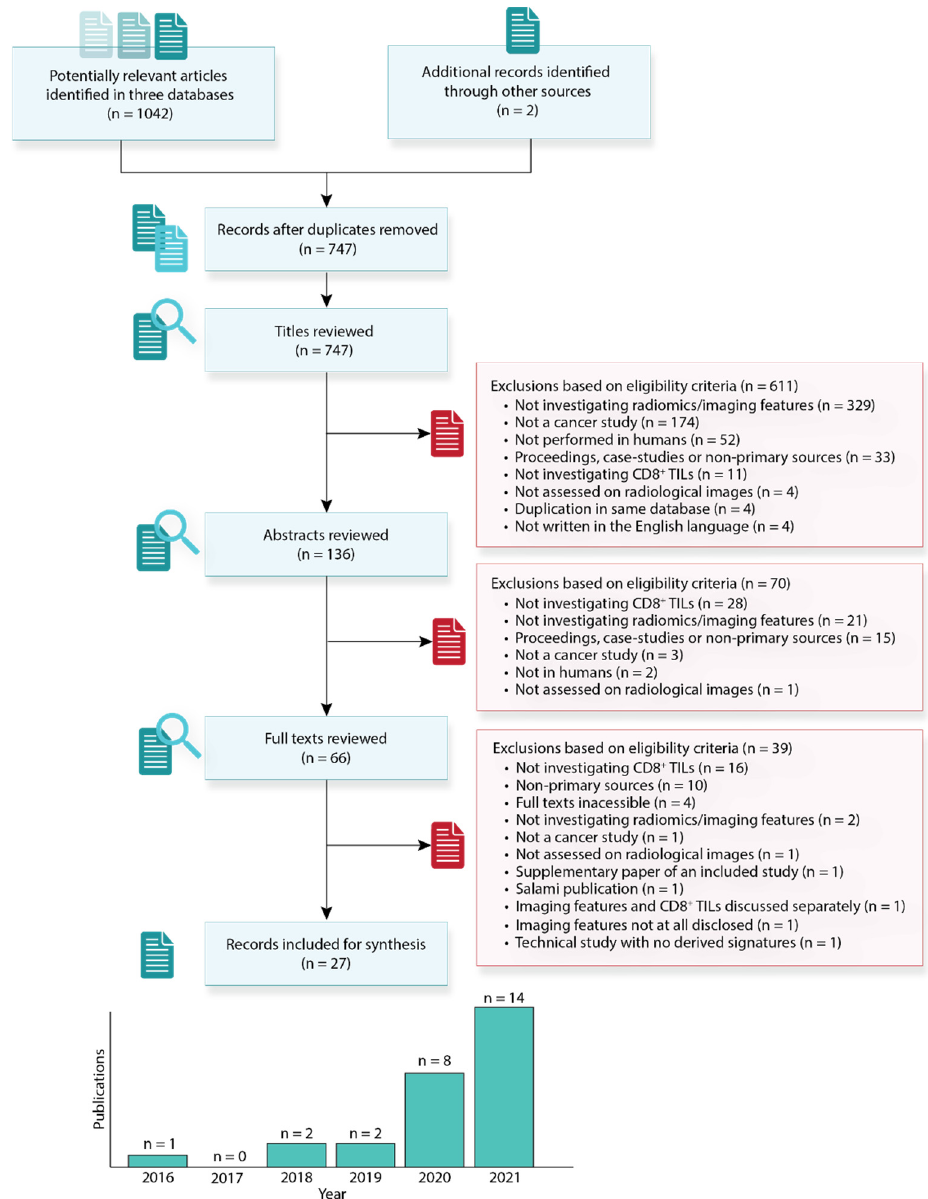
Figure 3. Flow diagram describing the literature selection process and the number of articles included according to the year of publication.